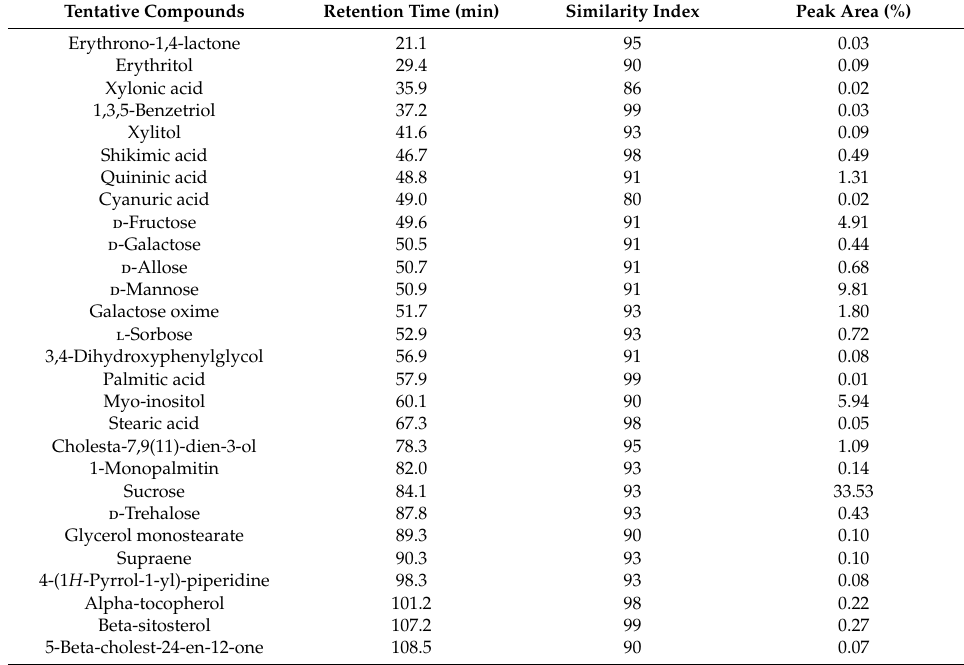
Table 1. Tentative compounds present in the P. malayana aqueous leaf extract detected by GC-MS.